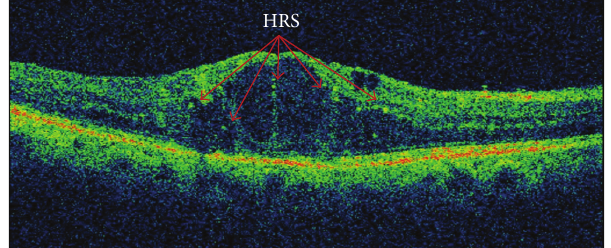
Figure 5: Cystoid diabetic macular edema with hyperreflective retinal